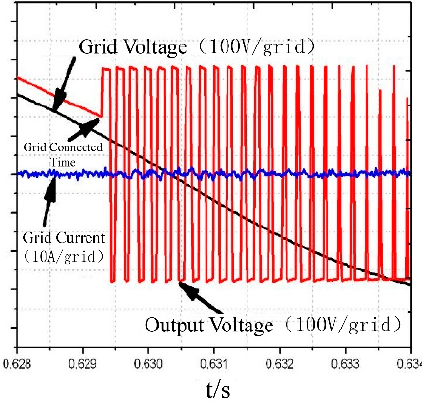
Figure 23. Parameters in grid connection.